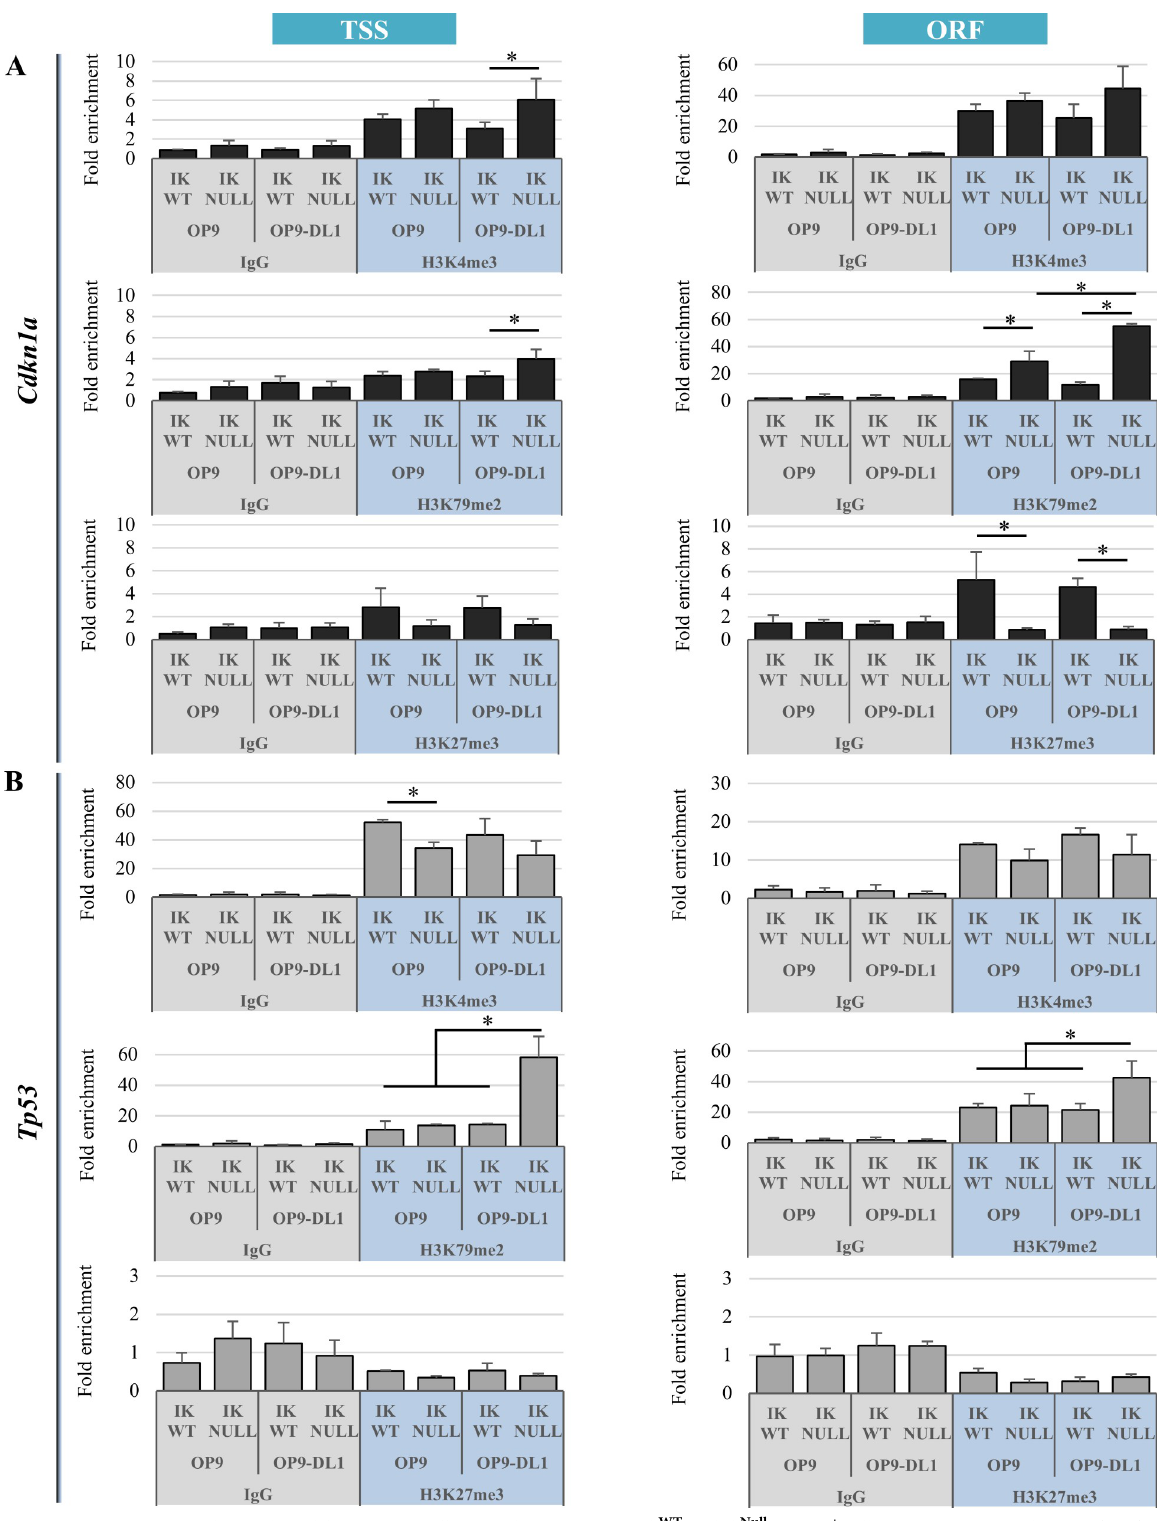
Fig 5. Histone post-translational modifications at Cdkn1a and Tp53 genes in Ik WT and Ik Null Ter119 + cells upon NOTCH induction. (A, B) ChIP assays with H3K4me3, H3K79me2, H3K27me3 antibodies (blue) or isotype-matched IgG (grey) were conducted in Ik WT or Ik Null Ter119 + cells co-cultured with OP9 or OP9-DL1 cells; immunoprecipitated and unbound (input) chromatin samples were used as templates in qPCR